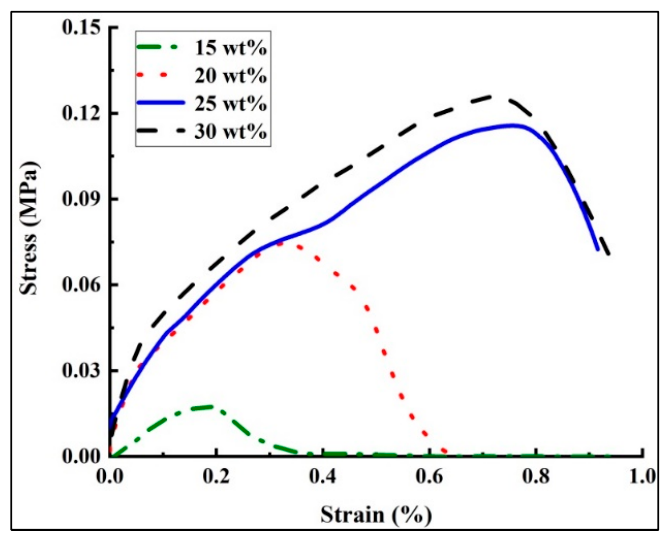
Figure 10. Stress–strain curves of different solution concentrations. The collecting time of the fiber mats was set to 120 min. The processing parameters were as follows: Applied voltage of 20 kV, working distance of 20 cm, and flow rate of 1.0 mL/h.